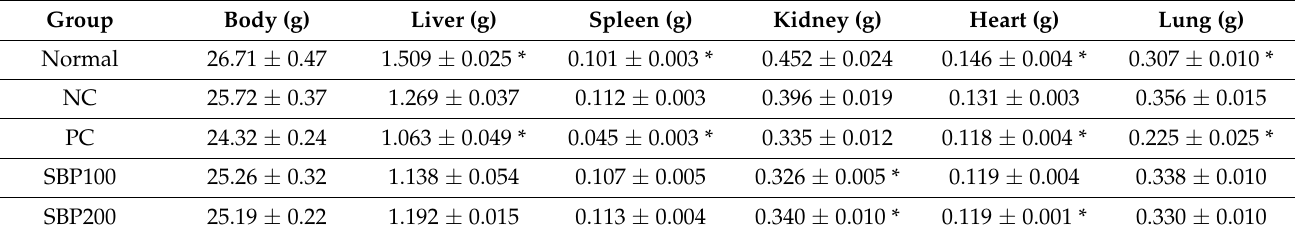
Table 3. Body and tissue weights of OVA/Alum − sensitized